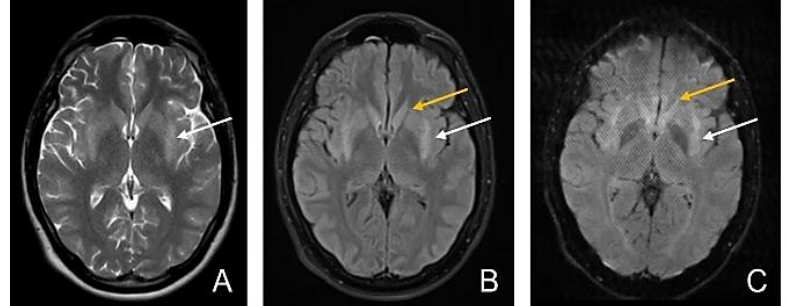
(yellow arrow) and putamen (white arrow) with slightly decreased signal in bilateral putamen.